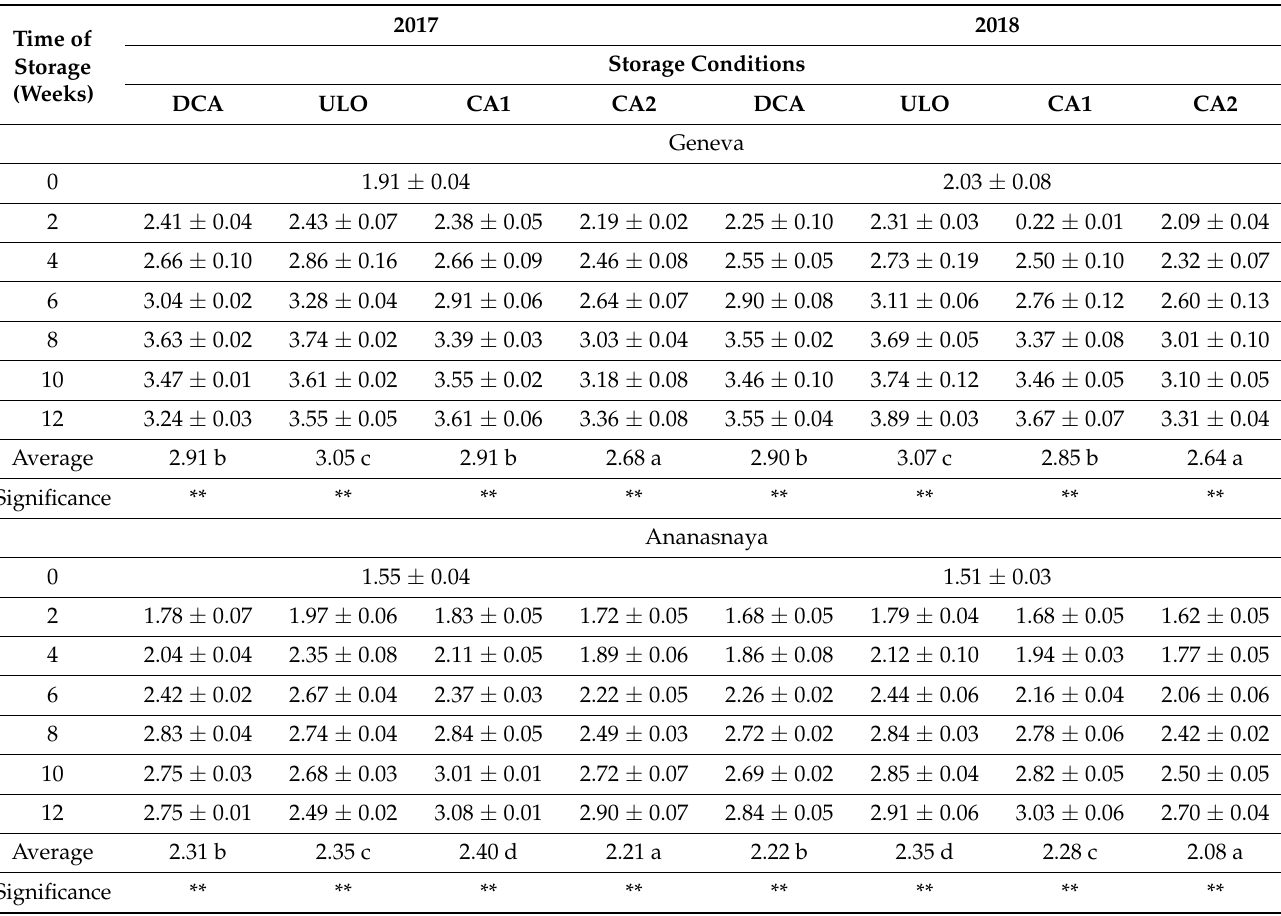
Table 4. Changes in glucose contents (g · 100 g − 1 F.W.) measured in ‘Geneva’ and ‘Ananasnaya’ minikiwi fruits in the postharvest